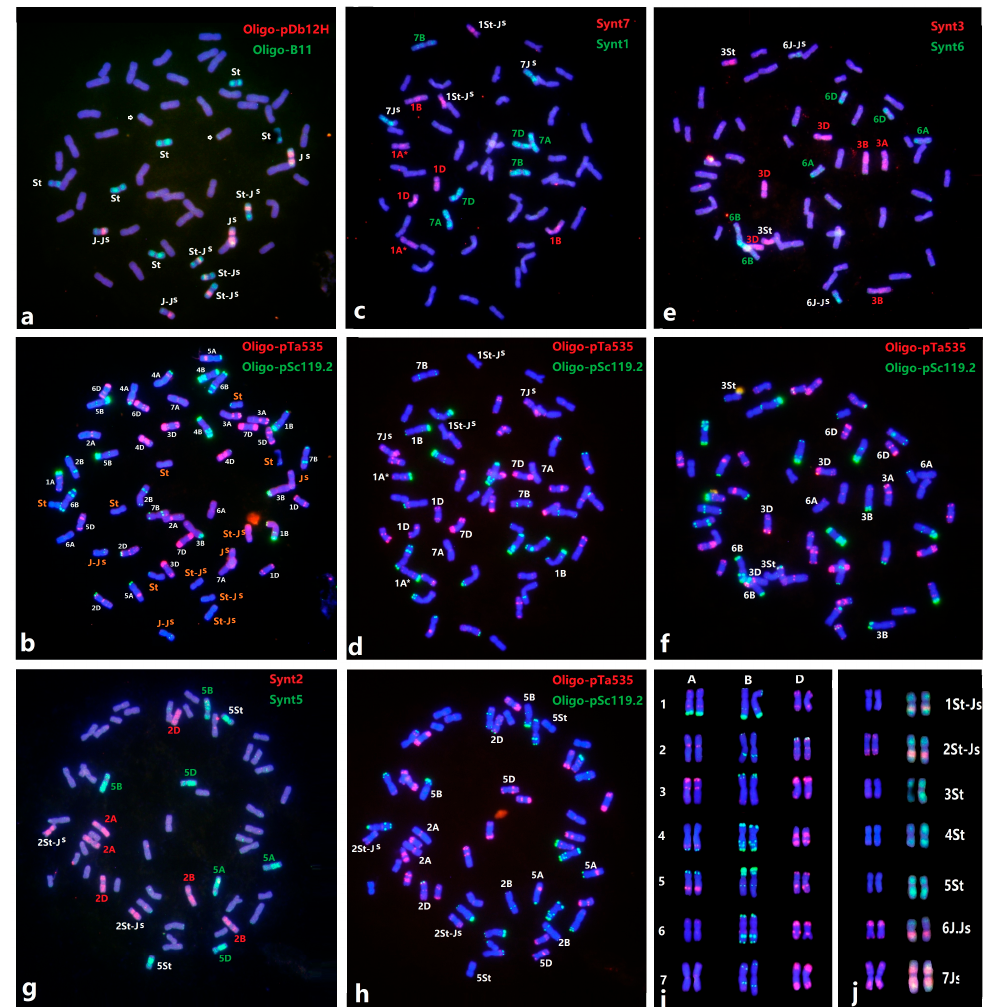
Figure 3. Sequential FISH probes Oligo-B11 + Oligo-pDb12H ( a ), Oligo-pSc119.2 + Oligo-pTa535 ( b , d , f , h ) and Oligo painting using specific bulked oligo probes Synt1+ Synt7 ( c ), Synt3 + Synt6 ( e ) and Synt2 + Synt5 ( g ) for wheat– Th. intermedium partial amphiploid 78829, respectively. Karyotypes of wheat chromosomes ( i ) and Th. intermedium ( j ) are shown. Chromosomes were counterstained with DAPI (blue). Arrows showed the wheat– Thinopyrum small translocation